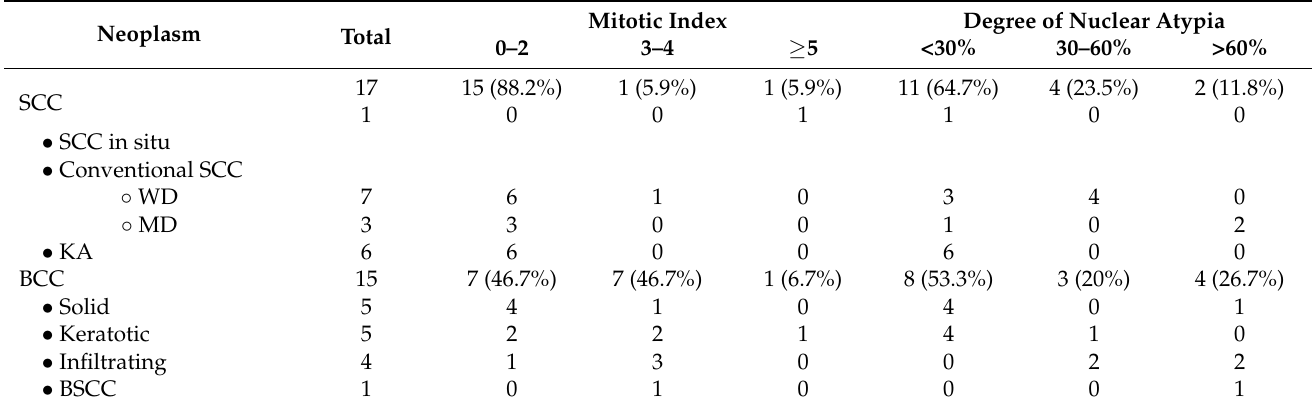
Table 3. Histological characteristics of 17 squamous cell carcinomas (SCCs) and 15 basal cell carcino- mas (BCCs) histological variants obtained from squamates and chelonians. The mitotic index and degree of nuclear atypia are specified for each histological variant. Neoplasm Total